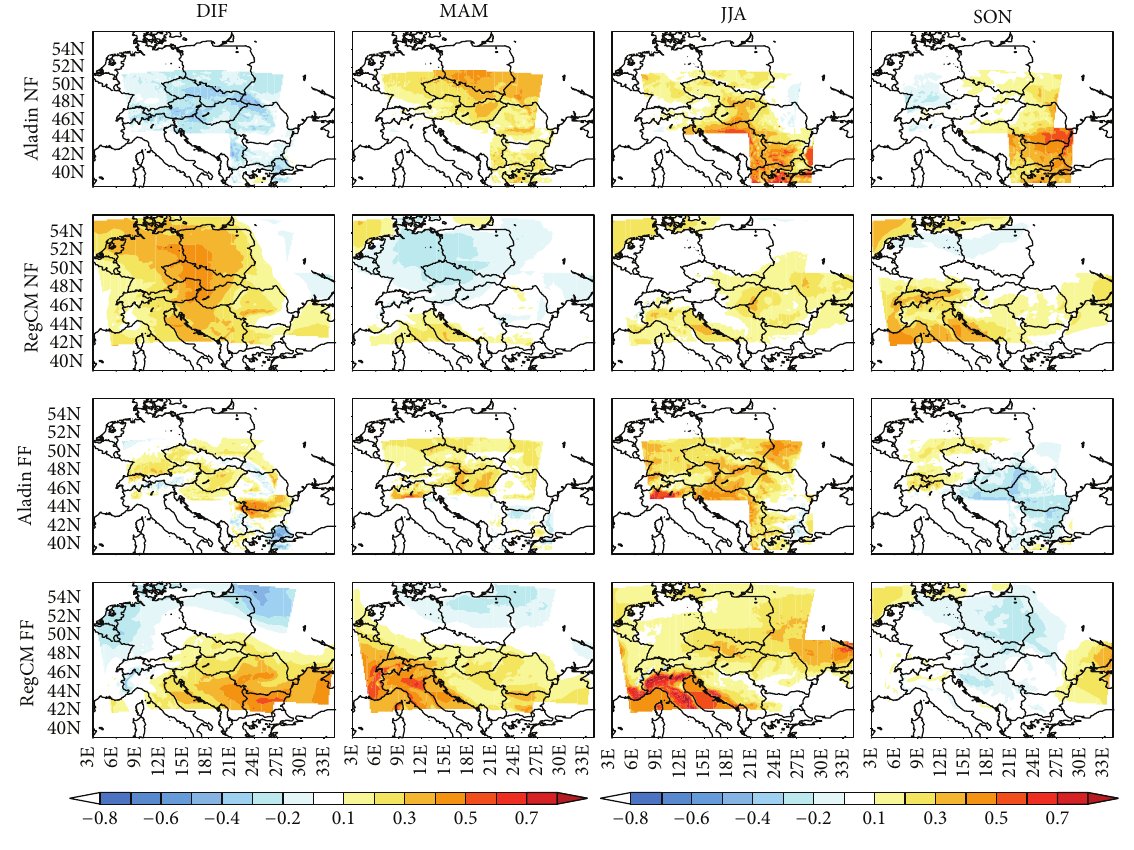
Figure 8: Change in 2m temperature interannual standard deviation. Units are ∘